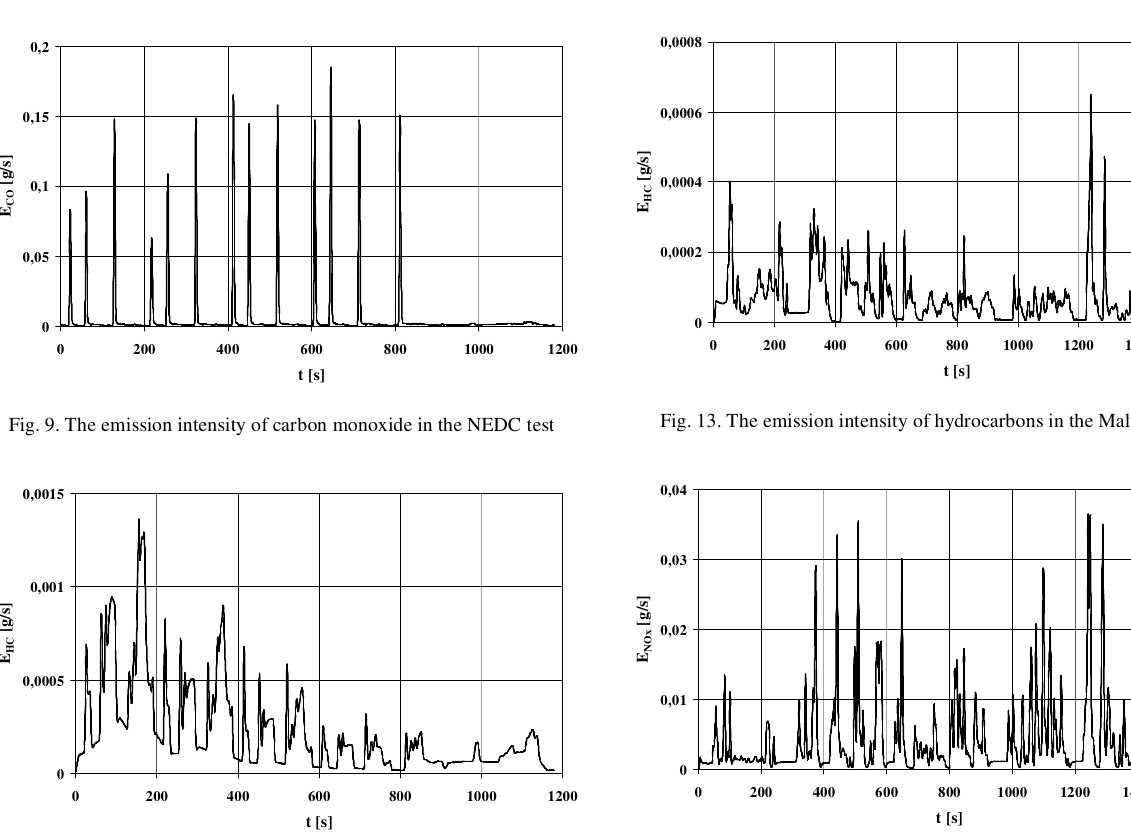
Fig. 14. The emission intensity of nitrogen oxides in the Malta